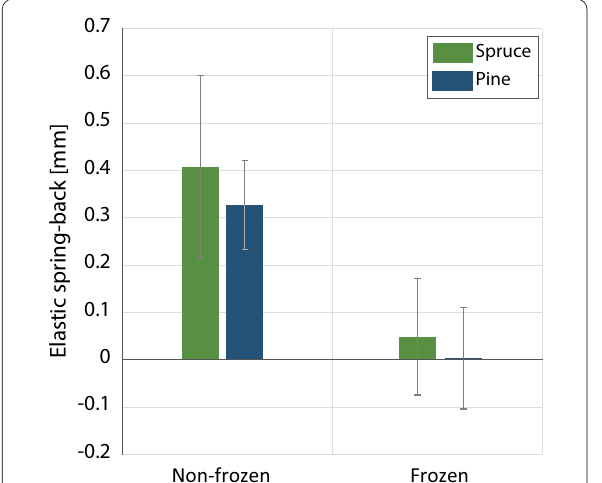
Fig. 7 Elastic spring-back of frozen and non-frozen Norway spruce and Scots pine